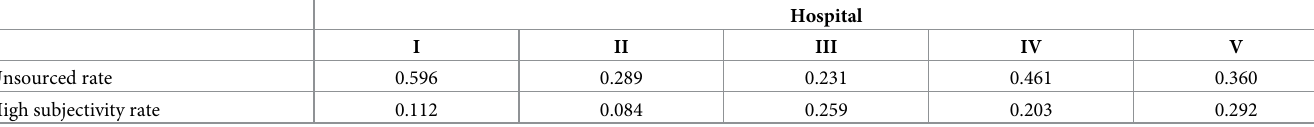
Table 8. Rate of unsourced and high subjectivity segments in institutions. Roman numerals indicate the five surveyed